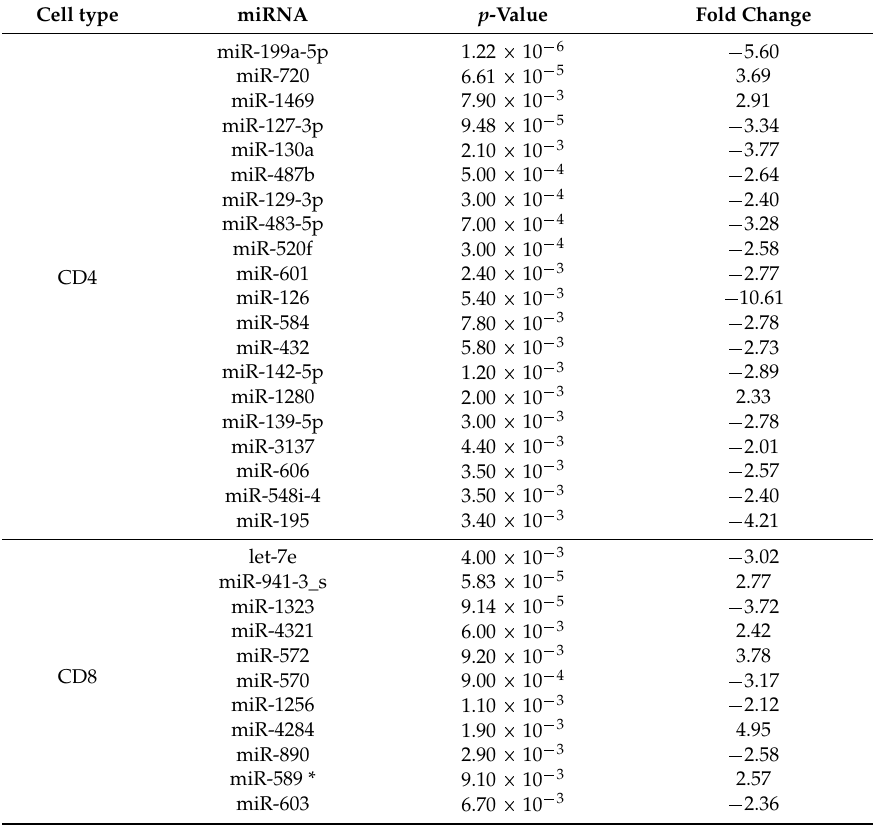
Table A1. Differentially expressed miRNAs in HIV+ CD4+ and CD8+ cells compared to negative controls. Non-FDR method. Infected n = 15, Uninfected n = 3 for each cell